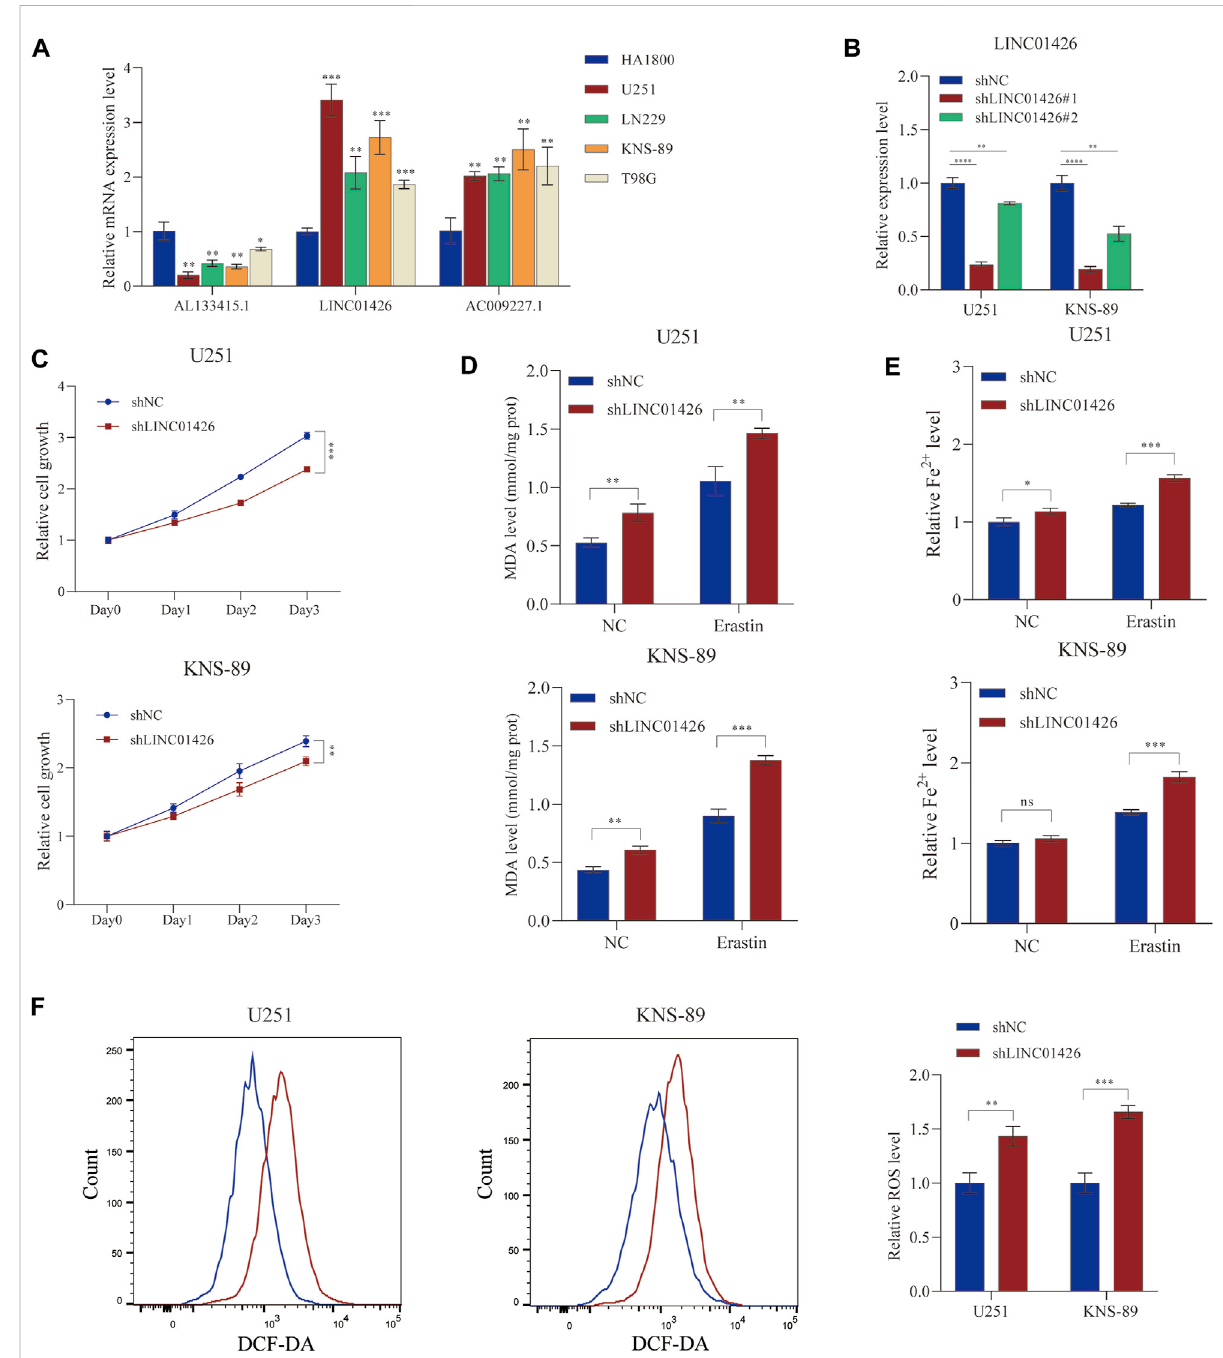
FIGURE 9 Validation of the expression level of the 3-FRLs in cell lines and ferroptosis regulation. (A) Expression analysis of 3-FRLs in four glioma cell lines (U251, LN229, KNS-89, T98G) with HA1800 lines (normal astrocytes). (B) Relative expression level of LINC01426 after transfection with the correspondingshRNA. (C) CellproliferationlevelsofU251andKNS-89afterknockingdownLINC01426. (D,E) Theferroptosisprocesswasevaluated by detecting MDA and Fe 2+ levels in the non-erastin-induced and erastin-induced groups. (F) The comparison of erastin-induced ROS in the treatment and control groups.* p < 0.05, ** p < 0.01, *** p < 0.001, and ns, No signi fi